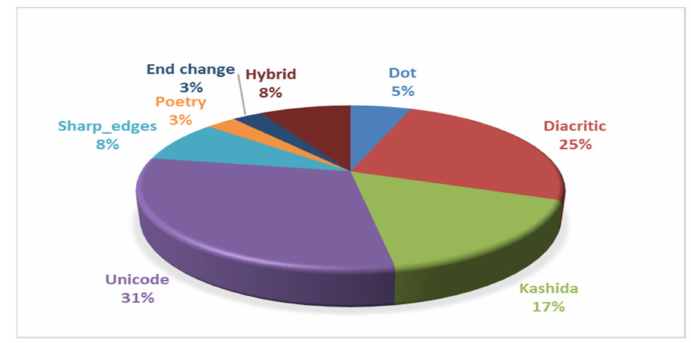
Figure 5. Usage of Arabic text steganography